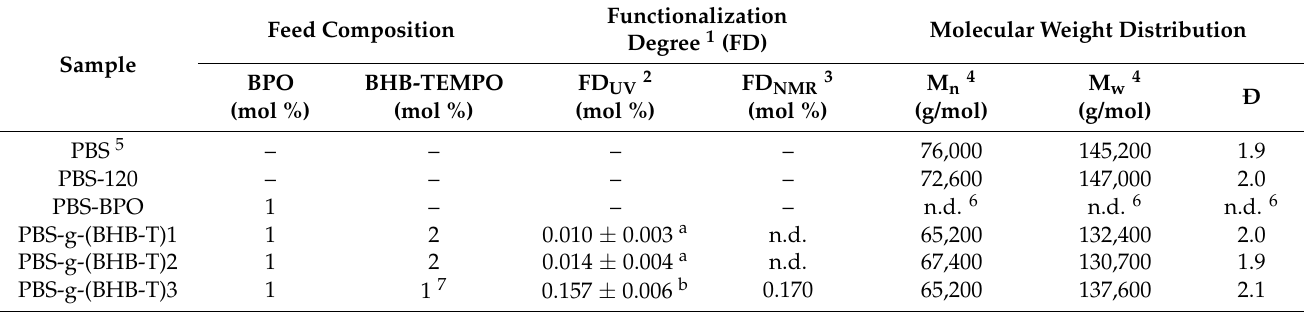
1 Functionalization Degree (FD): moles of the grafted functional groups with respect to 100 moles of monomer repeating unit. 2 Determined by the UV-Vis calibration curve. The value reported is an average of three different measurements with the corresponding standard deviation. Superscript letters (a, b) in the FD UV column indicate significant differences between samples (one-way ANOVA, p < 0.05): similar letters in a given test indicate